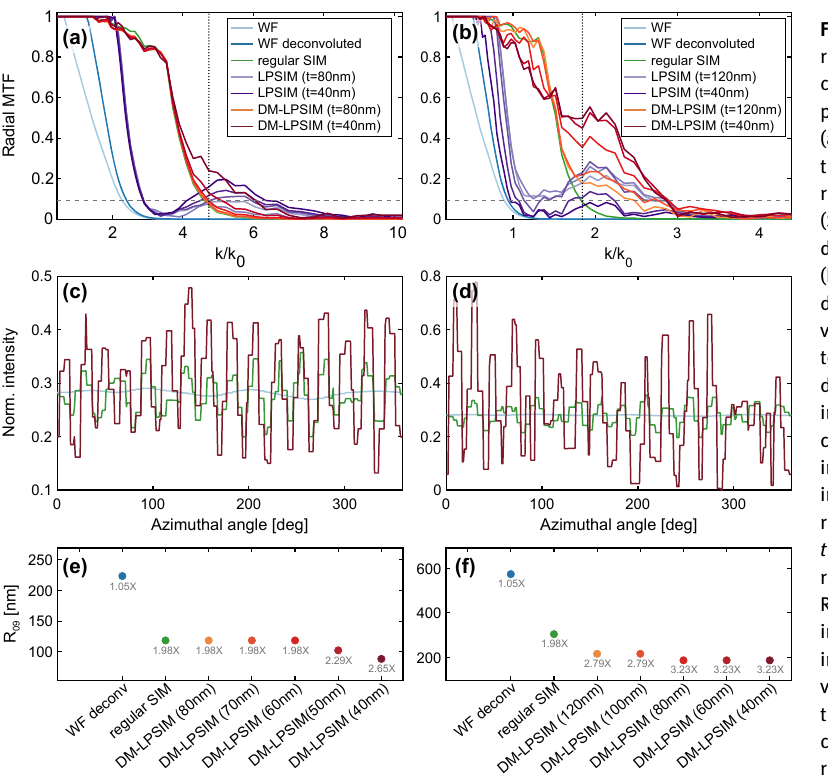
Figure 4: Quantitative assessment of the resolution enhancement in simulation configuration A 1 (left panels) and A 2 (right panels). (a,b) Modulation transfer function (MTF) of the reconstructed images for WF imaging, regular structured illumination microscopy (SIM), localized plasmon SIM (LPSIM), and double moiré localized plasmon SIM (DM-LPSIM). For LPSIM and DM-LPSIM, the distances t from the plasmonic array are varied from 40 to 80 nm for A 1 and from 40 to 120 nm for A 2 (smaller t correspond to darker hues). The dashed horizontal lines indicate the Rayleigh criterion of 9% contrast. (c,d) The normalized intensities at image cross-cuts along circles, which are indicated in Figure 3, for WF imaging (blue), regular SIM (green) and DM-LPSIM at t = 40 nm (dark red). (e,f) The minimally resolved distances according to the Rayleigh criterion. The resolution improvement compared to WF imaging is indicatedundereach data point.The dotted vertical lines in panels (a) and (b) indicate the normalized wave vectors at which the cross-cuts in panels (c) and (d) were taken,